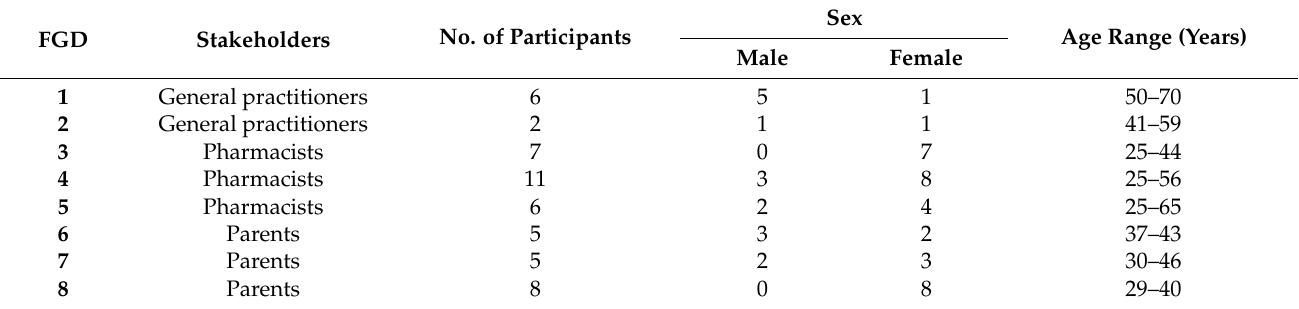
Table 1. Focus group discussion participation and participants’ demographic